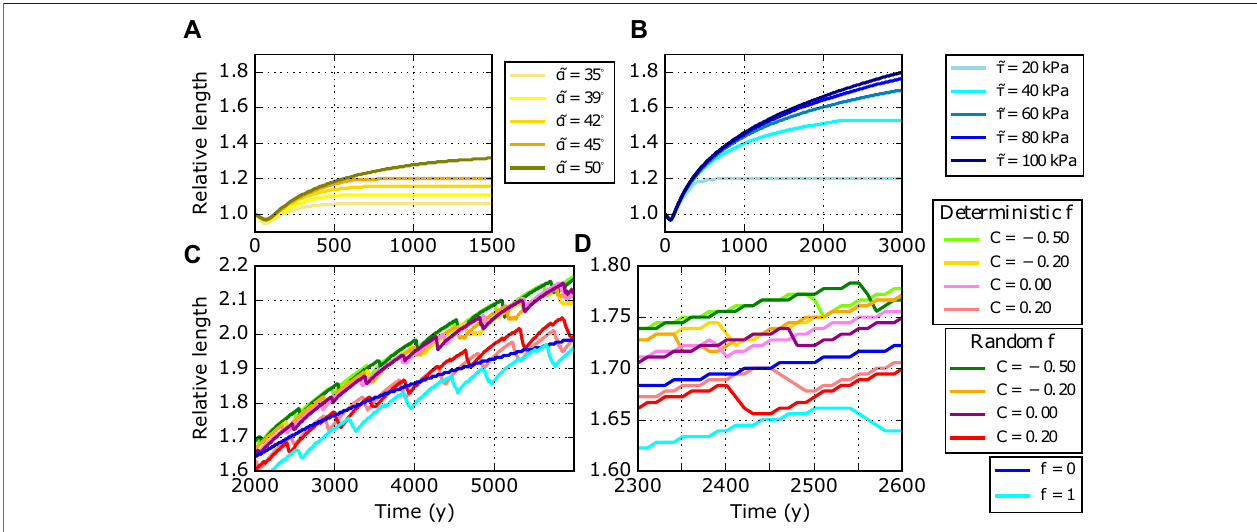
FIGURE 8 | Glacier length evolution for different debris removal and displacement mechanisms. (A) Slope-triggered debris removal; (B) driving-stress triggered debris removal; (C) deterministic and random slope-induced debris displacement combined with abrupt driving-stress triggered debris removal. Panel (D) is a zoom of (C) . Whereas in (A) and (B) the glaciers can reach steady state if ~ α or ~ τ are suf fi ciently low, in (C) the glaciers enter an oscillating state, which is superimposed to an advancing state. The larger the fraction of displaced debris (larger C or, equivalently, f → 1), the more enhanced are the